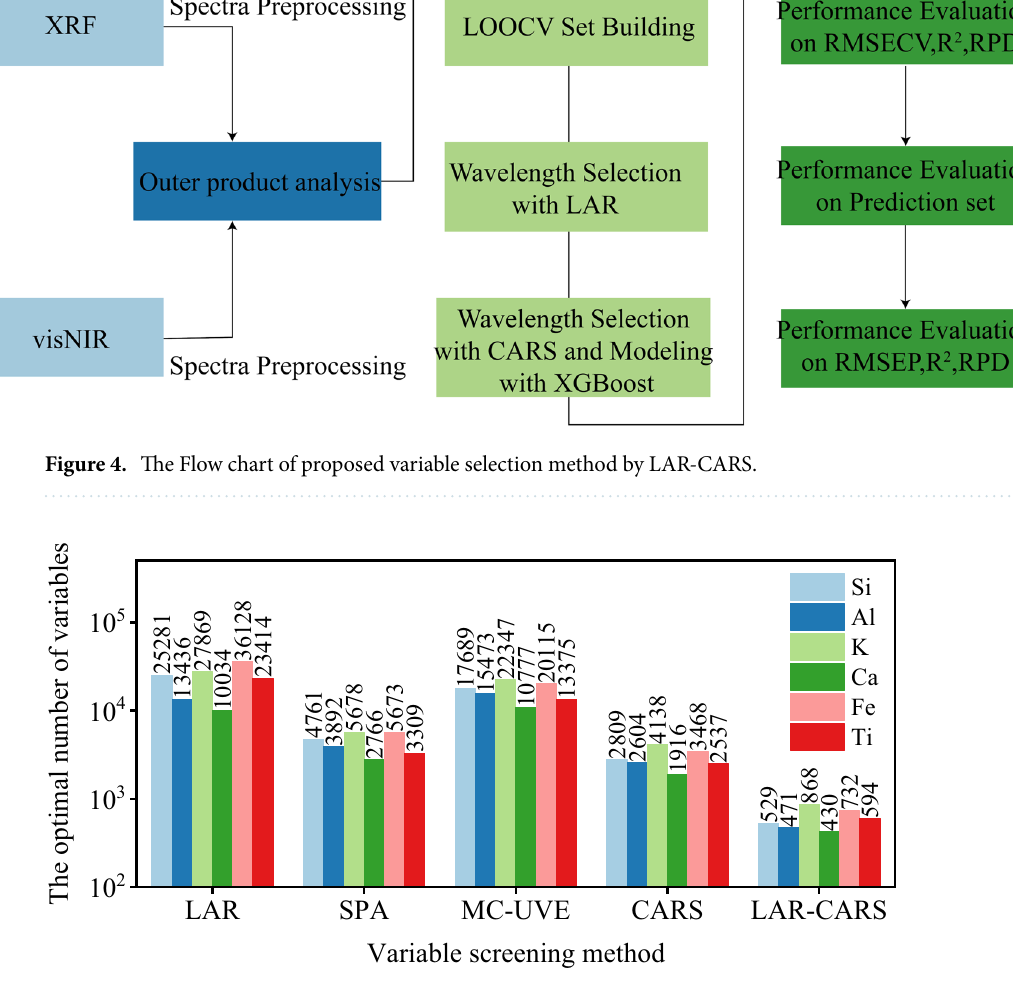
Figure 5. Number of optimal variables to